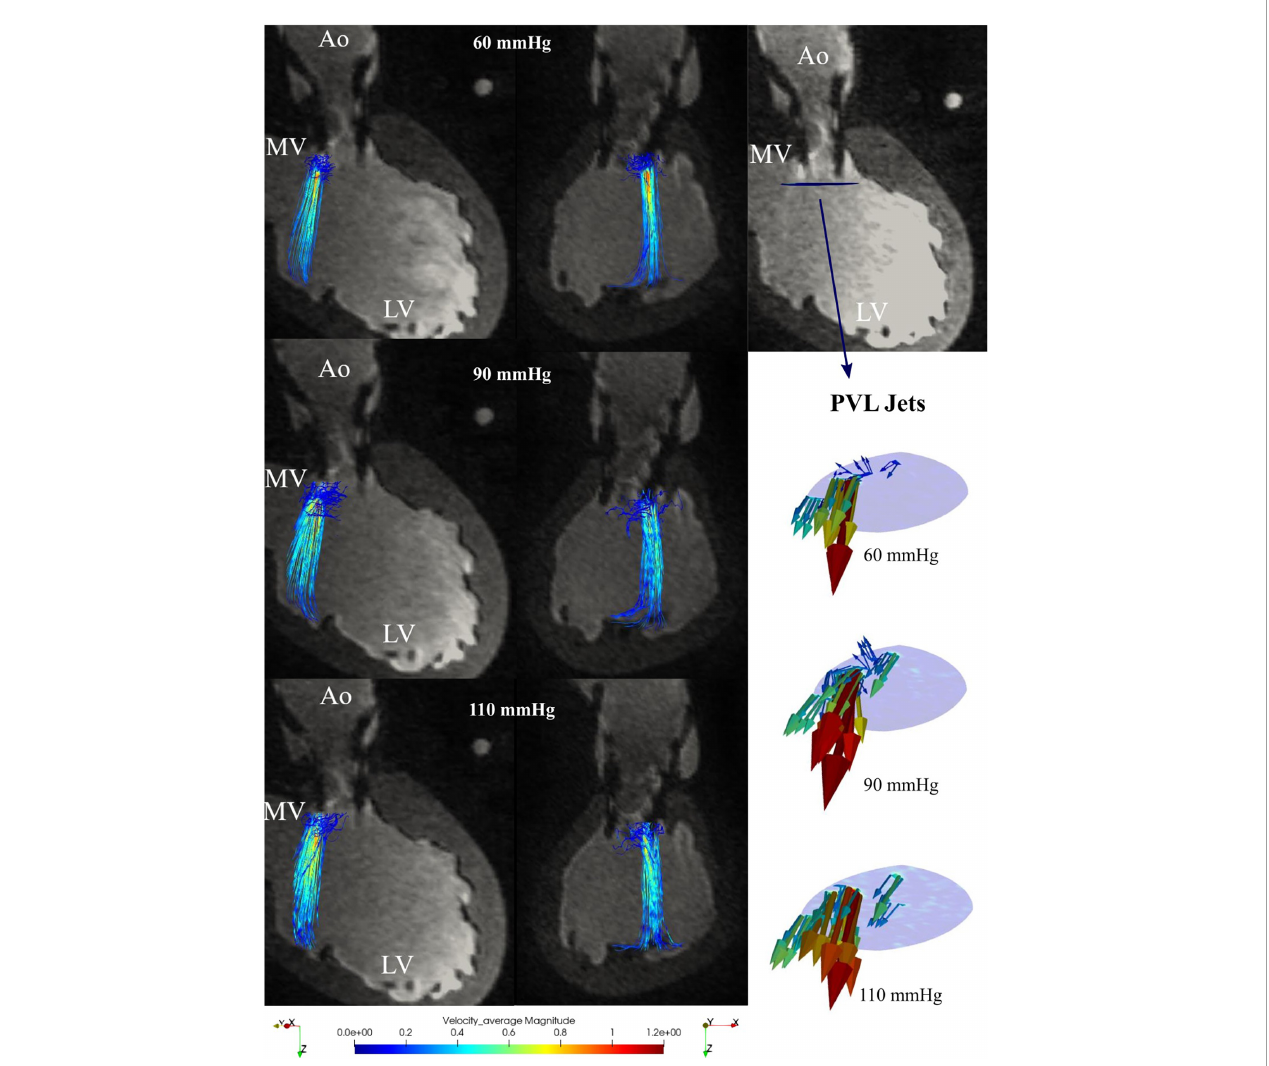
FIGURE6 Retrograde paravalvular leaks (PVL) streamlines for 60, 90, and 110 mmHg transvalvular pressure in the 3-chamber view (left) and the xz-plane (center) ; paravalvular jets in the plane directly below the transcatheter aortic valve implantation (TAVI) (right) .